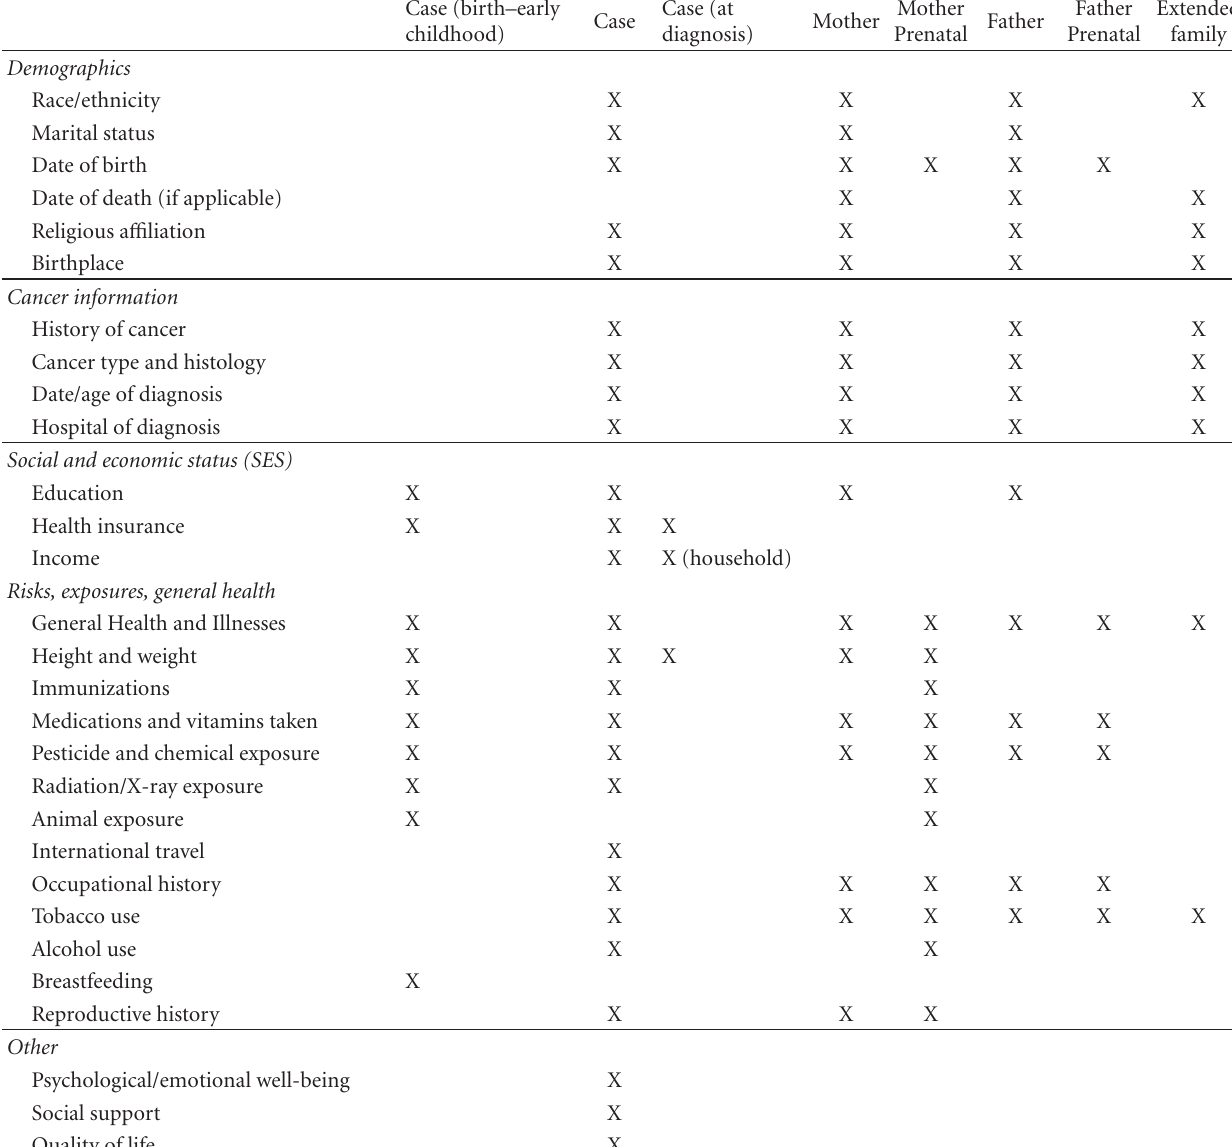
Table 1: Representative sample of variables collected in KAYAC case and parent